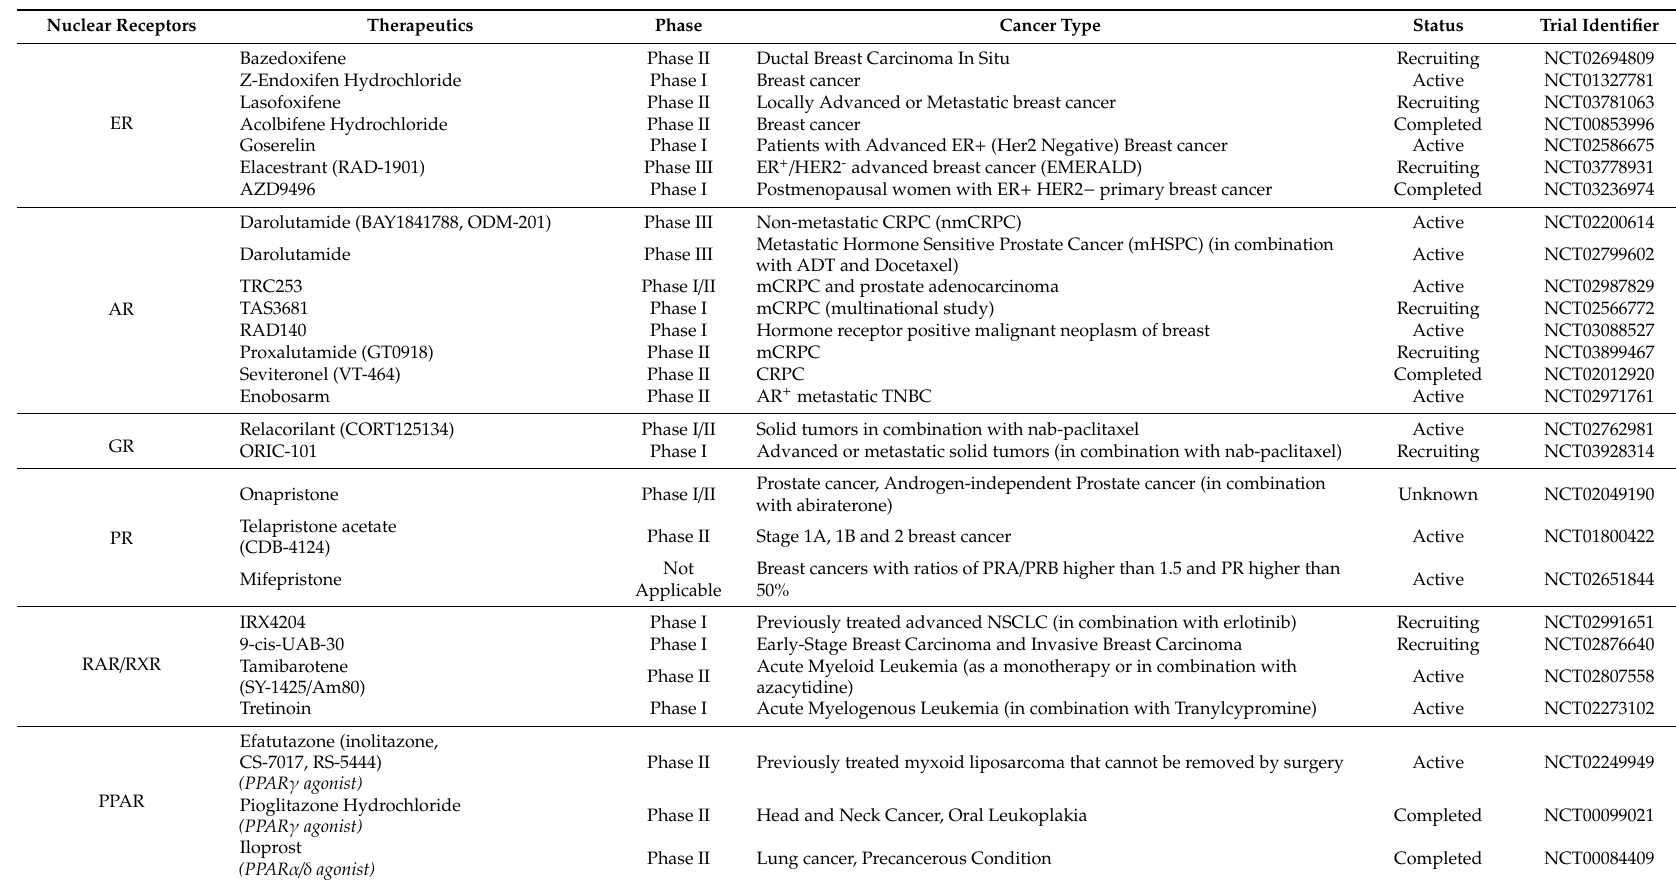
Table 3. Inhibitors against Nuclear Receptors in Clinical